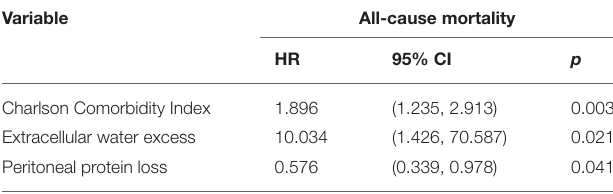
TABLE 3 | Risk factors predictive of